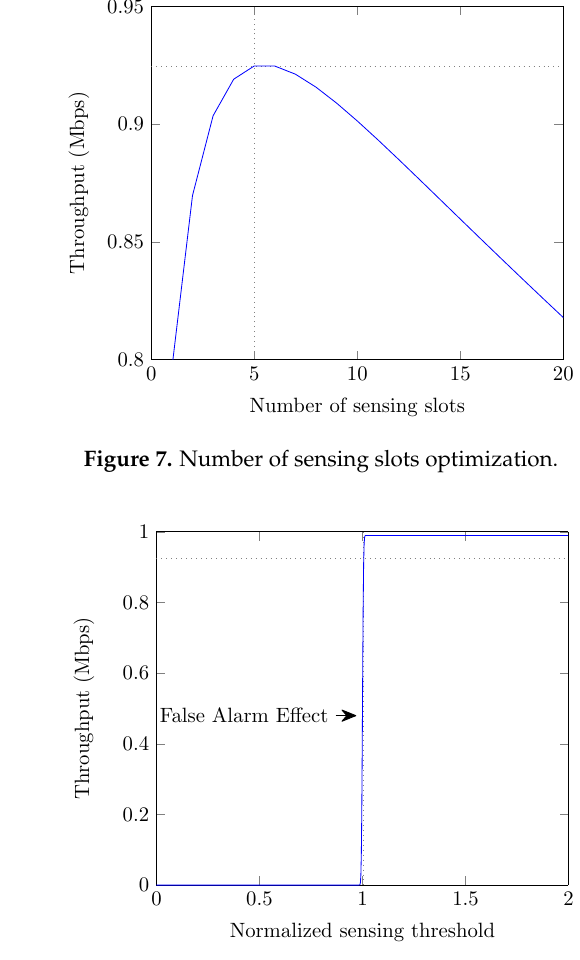
Figure 8. Throughput vs. normalized sensing